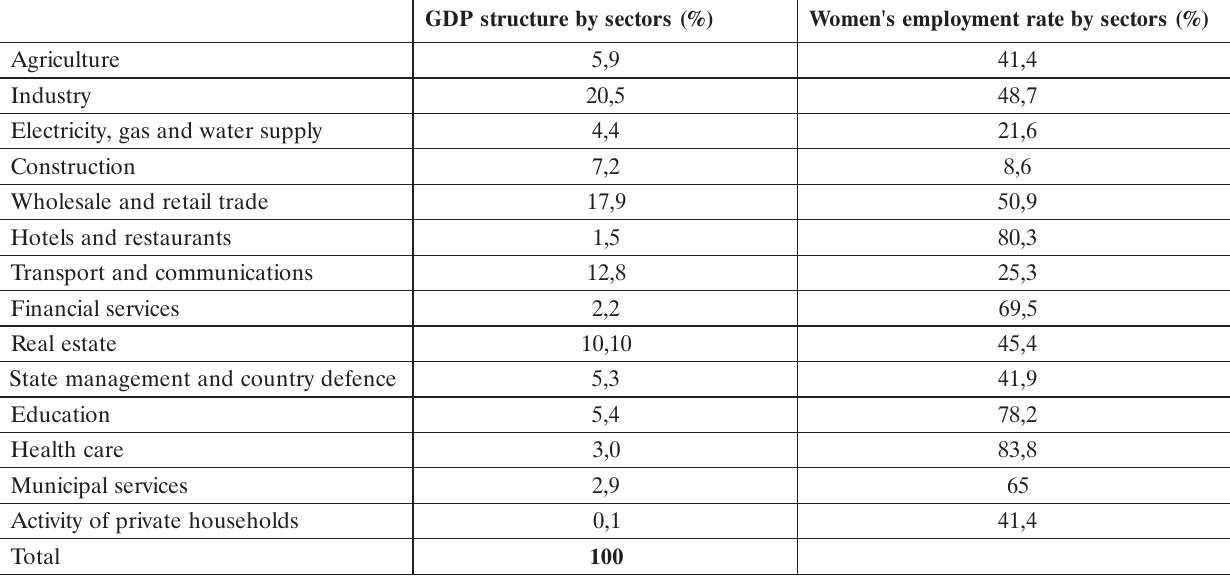
Table 2. Structure of Lithuania’s GDP and women’s distribution by branches of the economy in